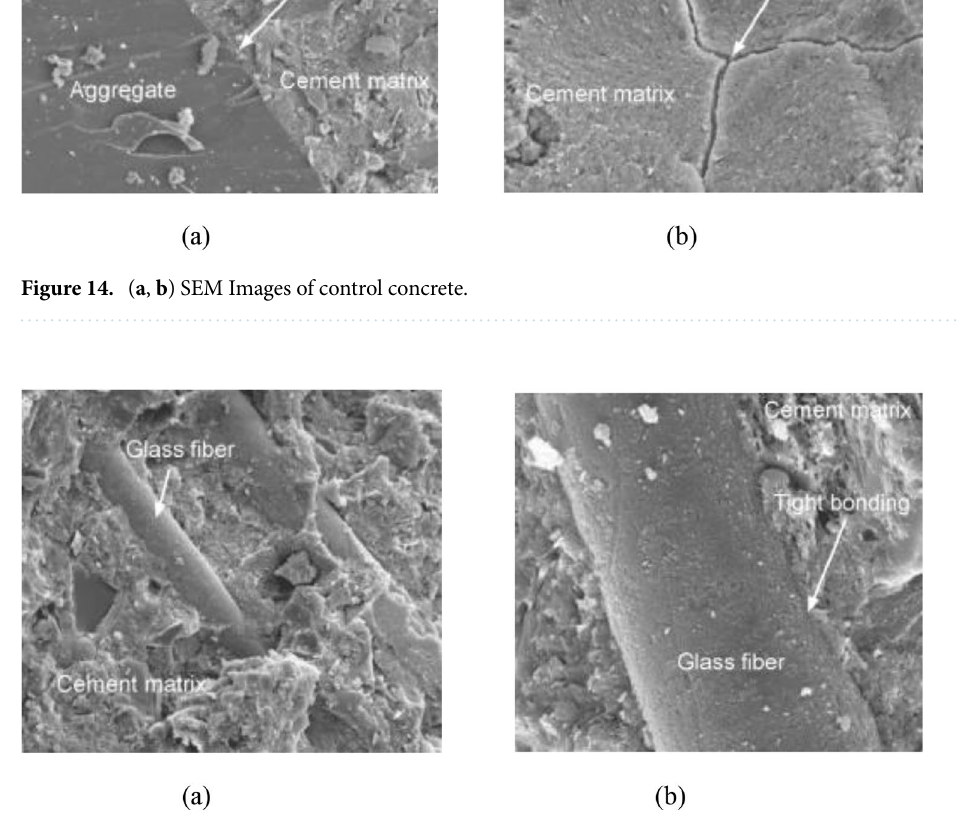
Figure 15. ( a , b ) SEM Images of concrete with glass